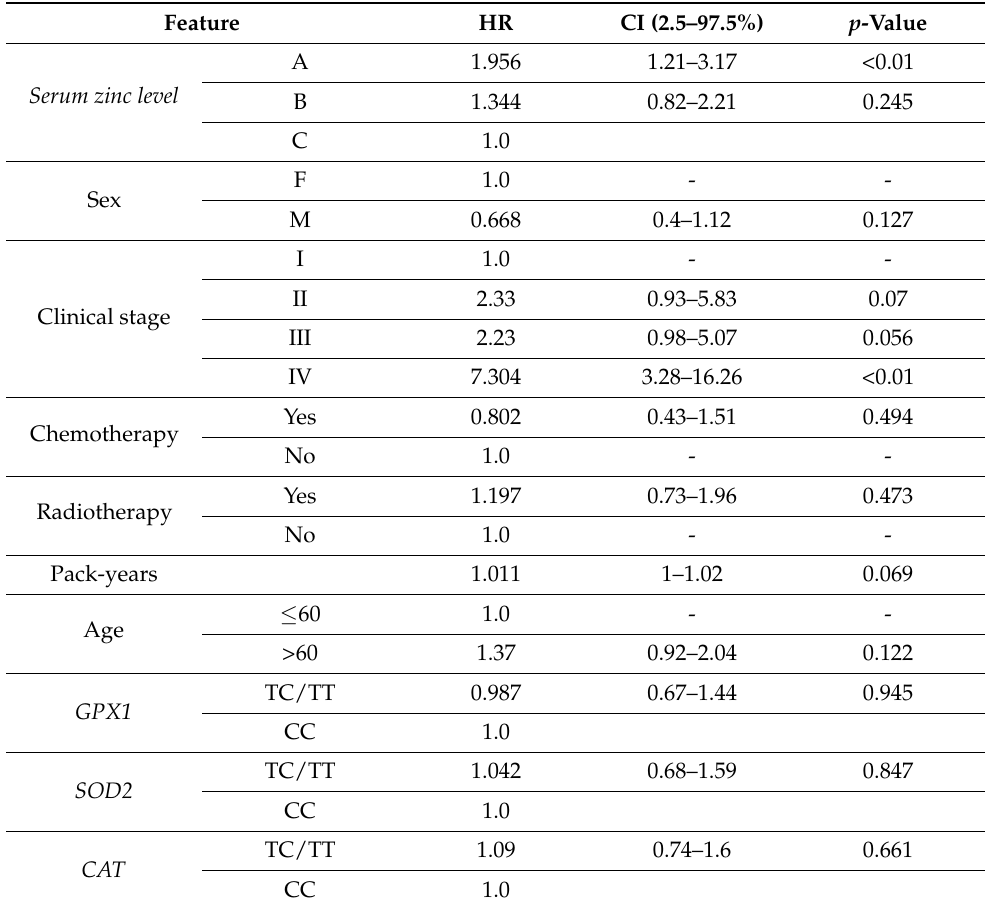
Table 3. Multivariable Cox regression (entire group, n = 300).